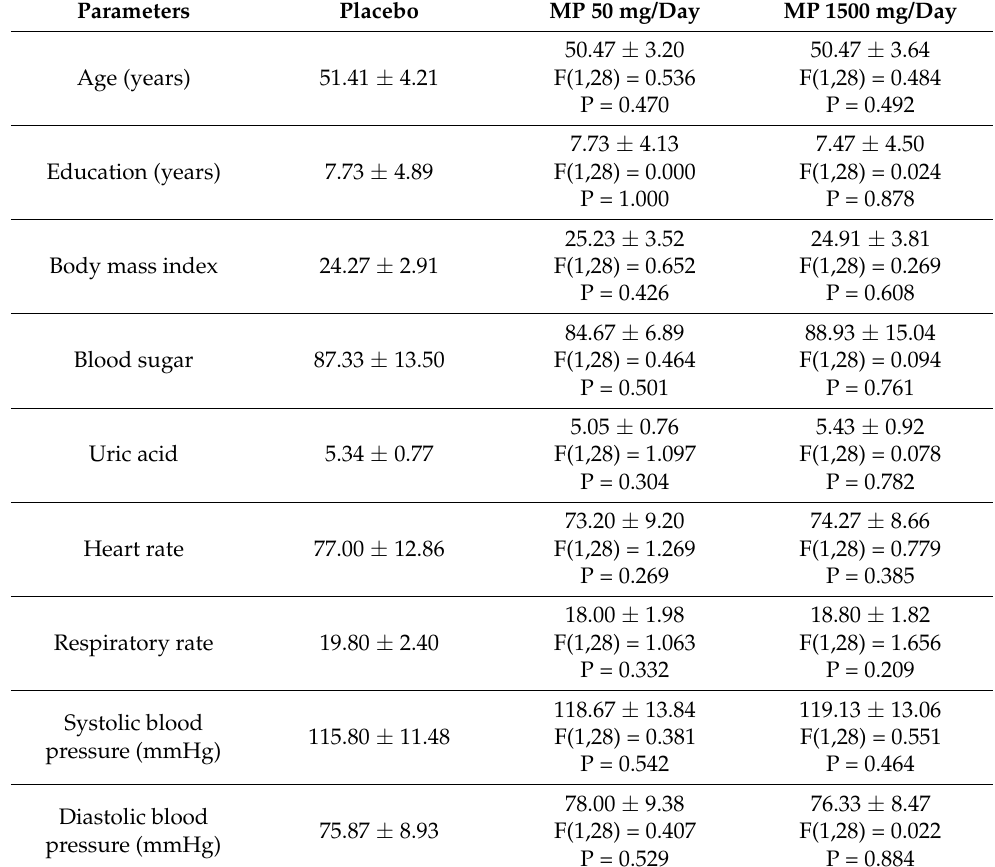
Table 1. The demographic data of subjects.